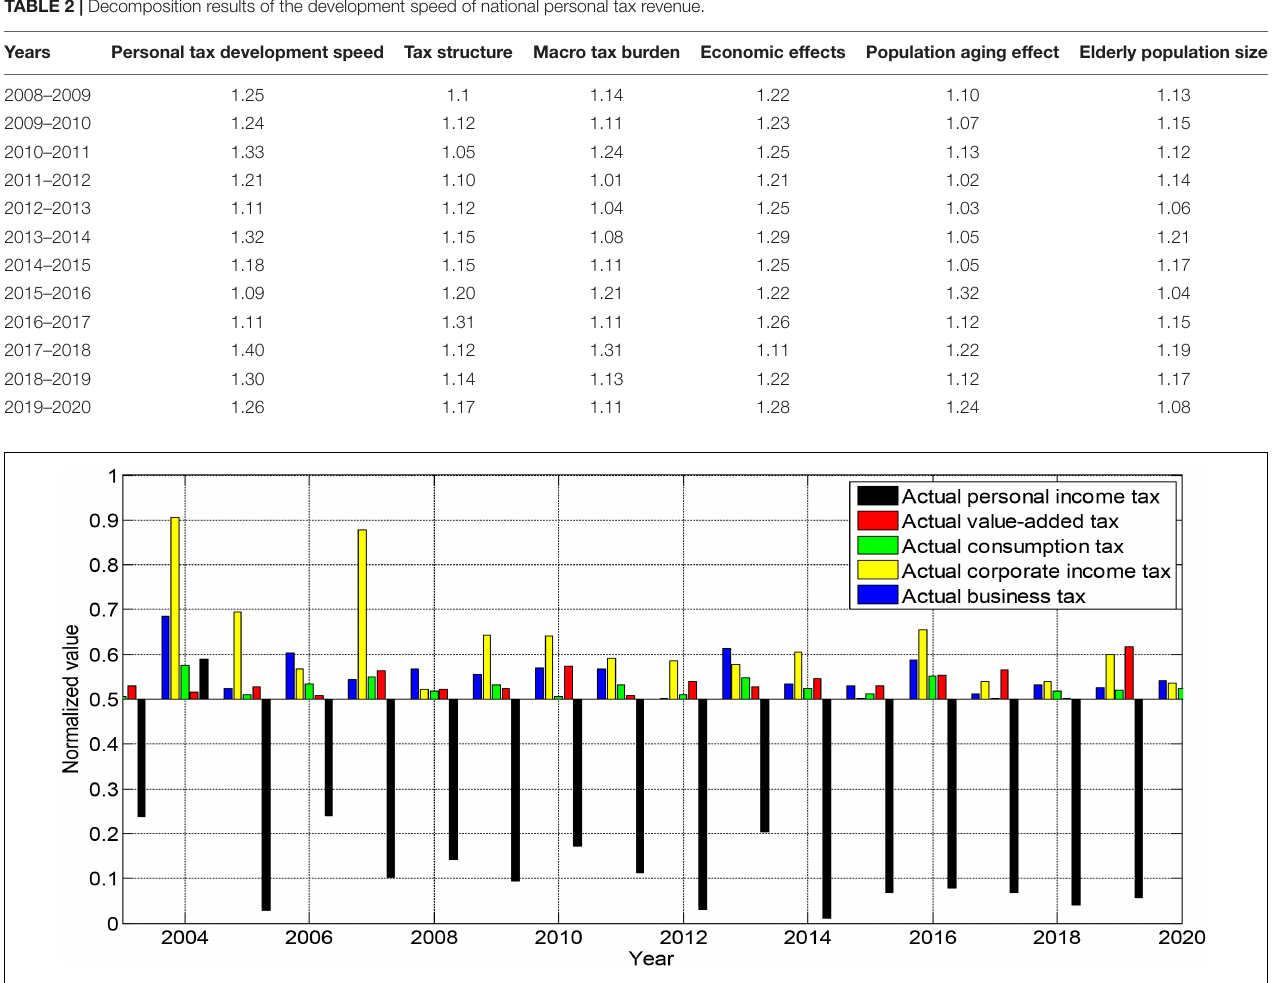
FIGURE 4 | Normalized 2003–2020 data